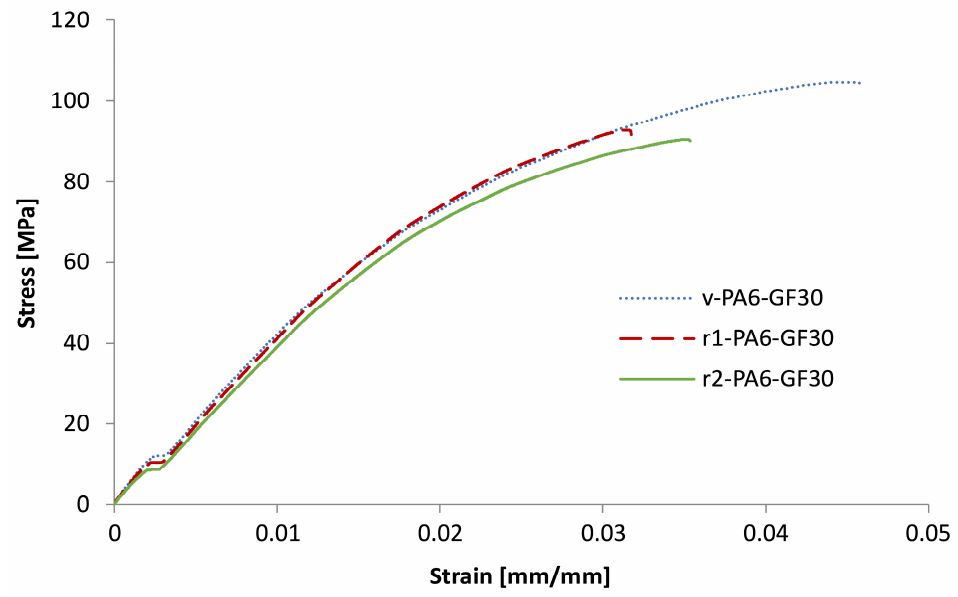
Figure 5. Stress–strain curve of each processing cycle of PA6-GF30. The changes in mechanical properties (Figure 6) from v-PET to r1-PET can be related to the higher melt flow rate, as shown in Table 5, which might promote higher molecular orientation. After a second recycling cycle, the results show that there is a notorious loss of properties, displaying the characteristics of a fragile material.